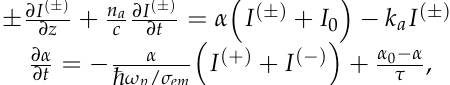
Figure 8. The simulation results of the mode ‐ locked laser oscillation for the shutter with t open = 2 ns at ( a ) φ = 17°, ( b ) φ = 27°, and ( c ) φ = 37°.